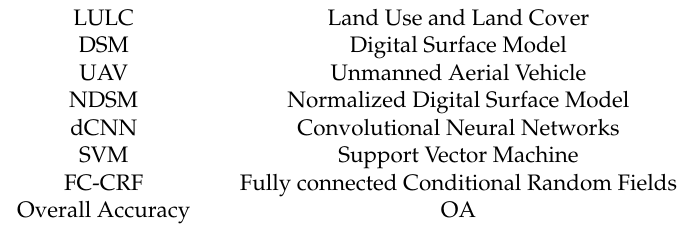
Table 1. List of some important items and corresponding